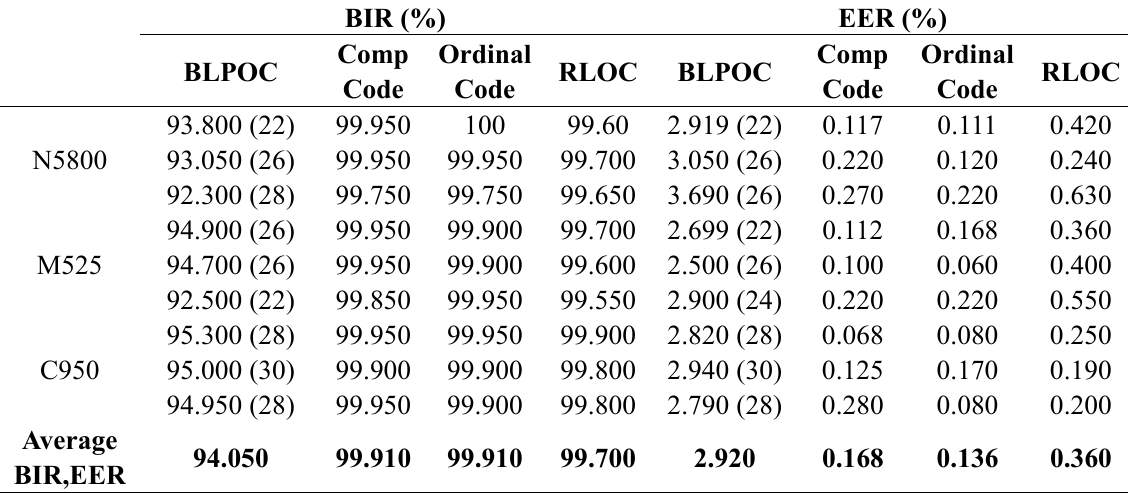
Table 2. BIRs and EERs of BLPOC and three orientation coding based methods conducted three times on three sub-databases (The value of J BIR or lowest EER is listed in brackets).